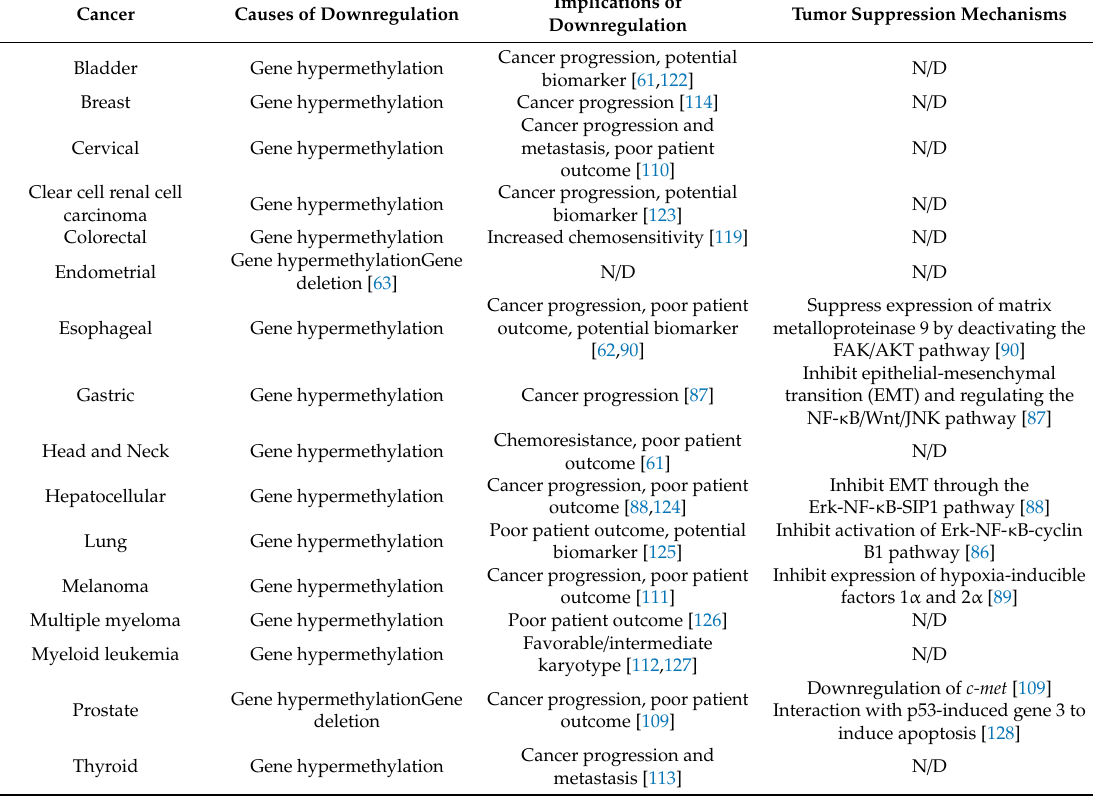
Table 1. Examples of studies demonstrating GPx3 downregulation in tumor tissues. Mechanisms of GPx3 expression loss and implications of GPx3 downregulation on tumor cells and pro-tumorigenic signaling are summarized if reported (N / D: not determined).